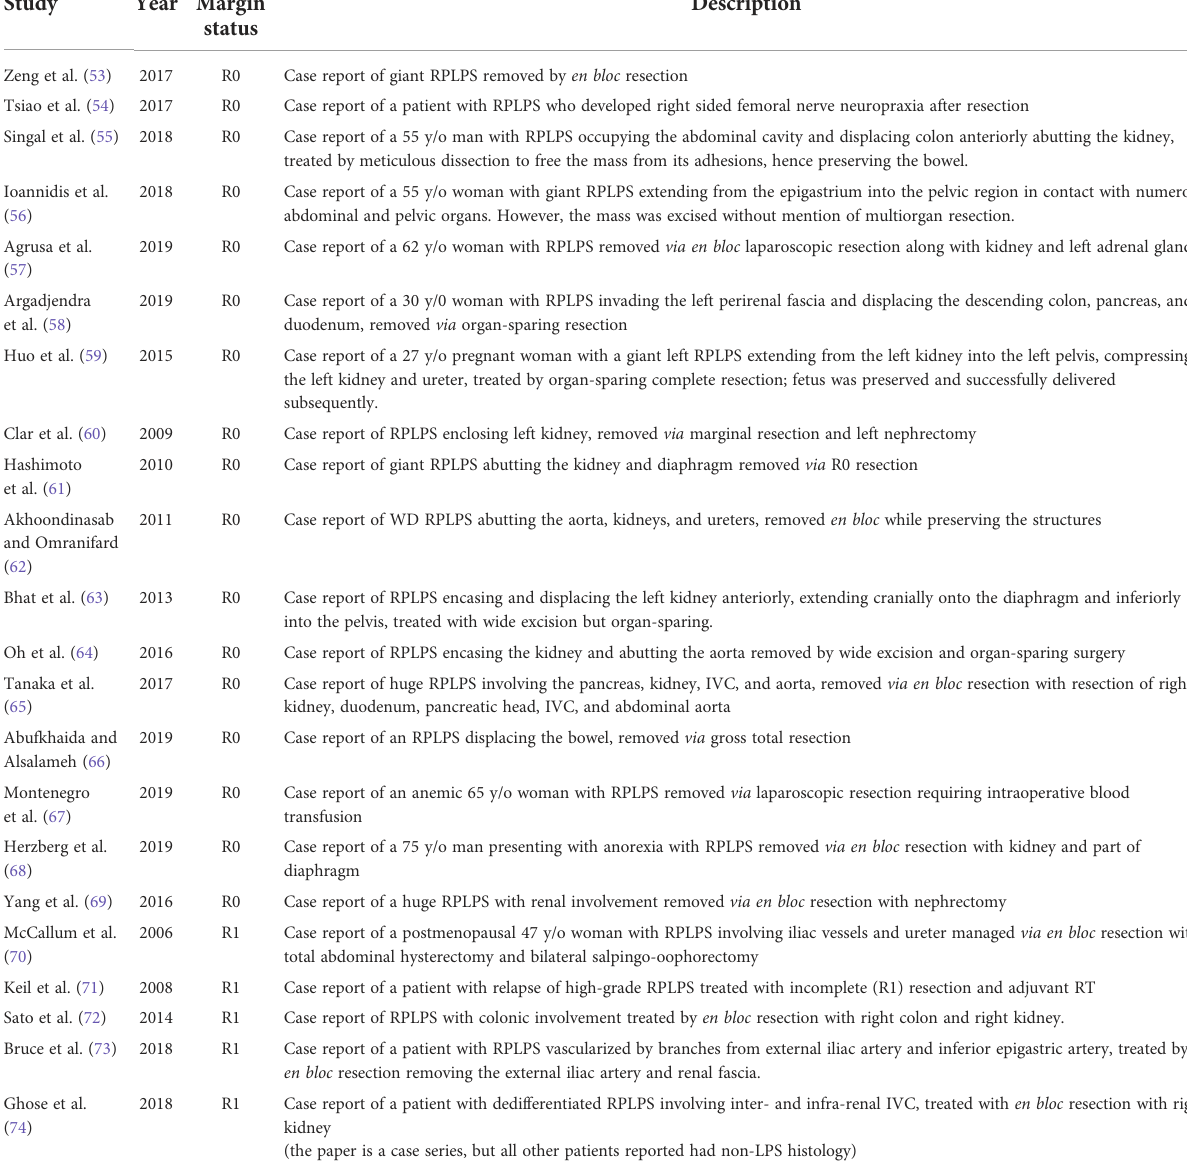
the recurrence and survival outcomes of RPLPS patients receiving R1-margin resection for